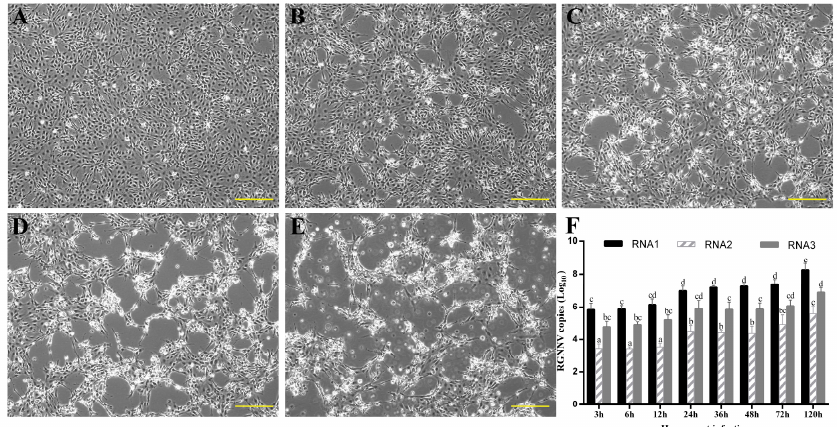
Figure 4. The changes in SSN-1 cell lesions and viral genome expression at different time points after NNV infection. ( A – E ): SSN-1 cell infected for 0 h, 24 h, 48 h, 72 h, 120 h. Scale bar = 100 μ m. ( F ): qRT-PCR technique to detect intracellular viral genomes. Lowercase letters indicate significant differences between treatments ( p < 0.05).